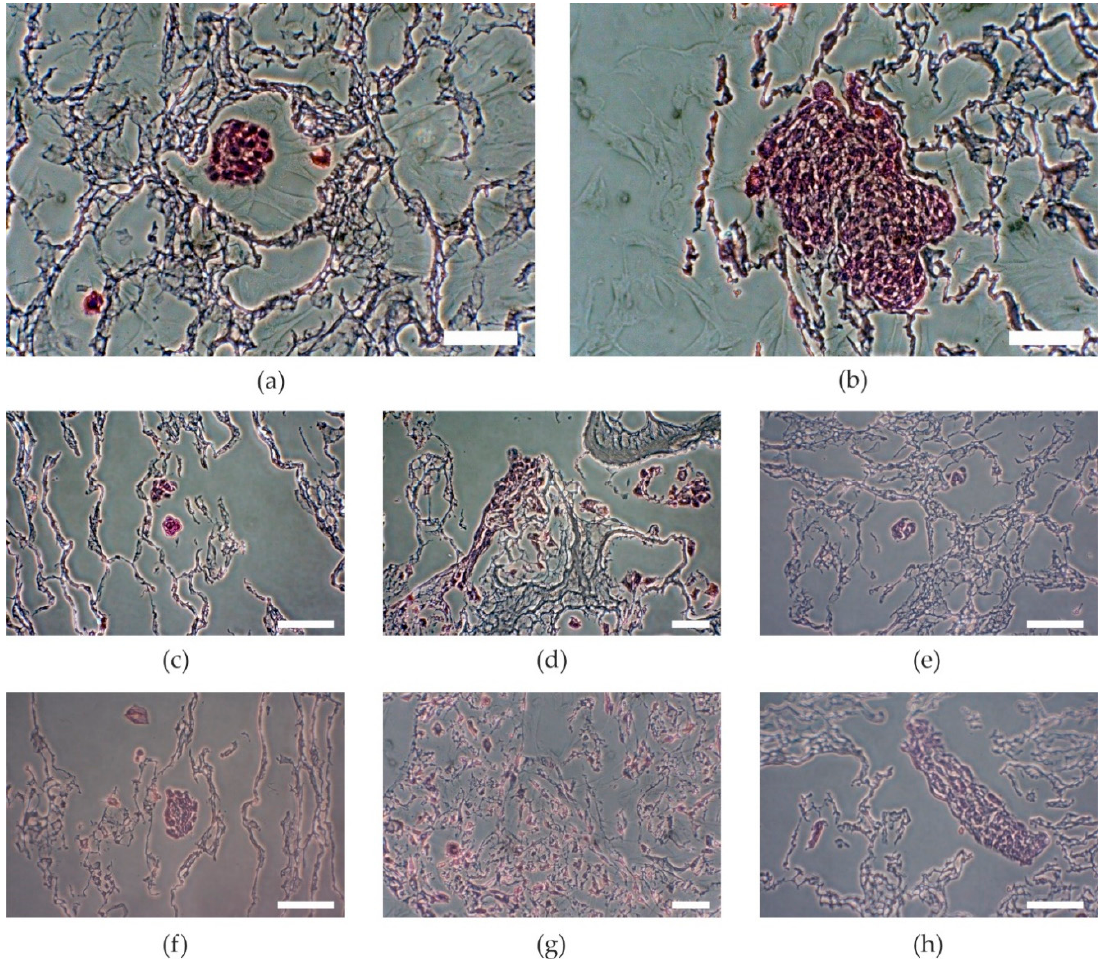
Figure 3. Visual comparison of MG-63 cell colonies stained with hematoxylin and eosin. ( a ) Sample A, ( b ) sample B, ( c ) sample HA1, ( d ) sample HA2, ( e ) sample HA3, ( f ) sample HB1, ( g ) sample HB2, ( h ) sample HB3. A: PVA / HA = 3:1; HA1: PVA / HA / Hap = 3:1:1; HA2: PVA / HA / Hap = 3:1:2; HA3: PVA / HA / Hap = 3:1:3; B: PVA / HA = 1:1; HB1: PVA / HA / Hap = 1:1:1; HB2: PVA / HA / Hap = 1:1:2;